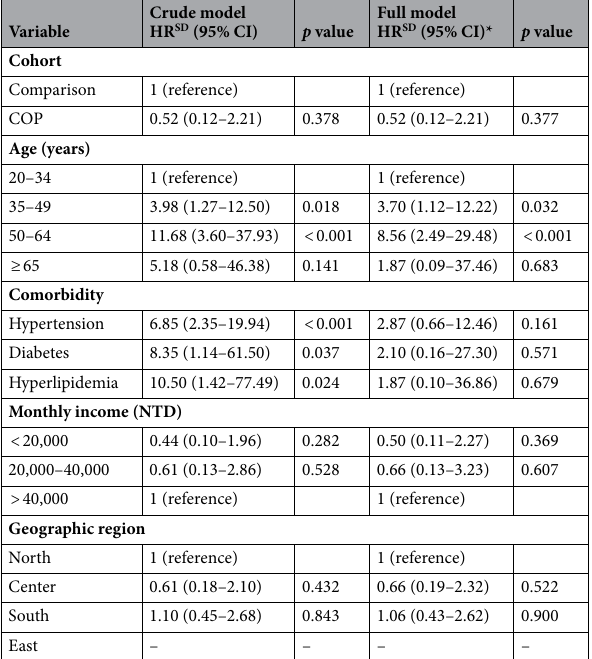
Table 3. Independent predictors for breast cancer in all patients of the two cohorts in the first year of follow-up. The independent predictors were identified through competing risk regression analysis. COP carbon monoxide poisoning, HR hazard ratio, AHR adjusted hazard ratio, HR SD adjusted competing risks hazard ratio, CI confidence interval, NTD New Taiwan Dollars. *Adjusted for age, hypertension, diabetes, hyperlipidemia, monthly income, and geographic